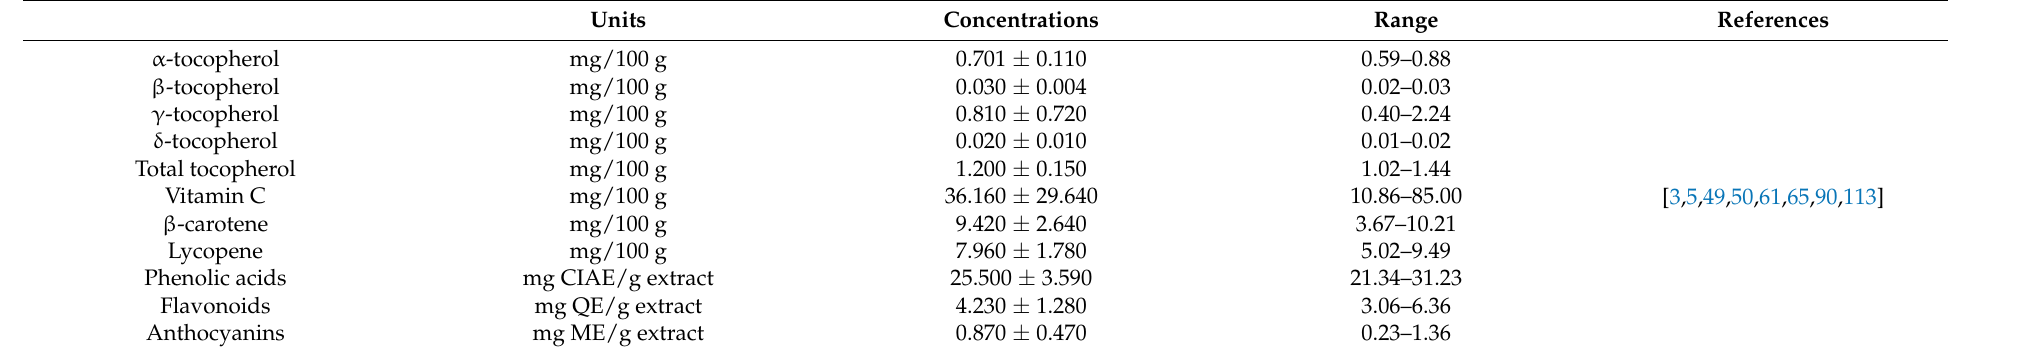
Table 8. Antioxidant constituents in